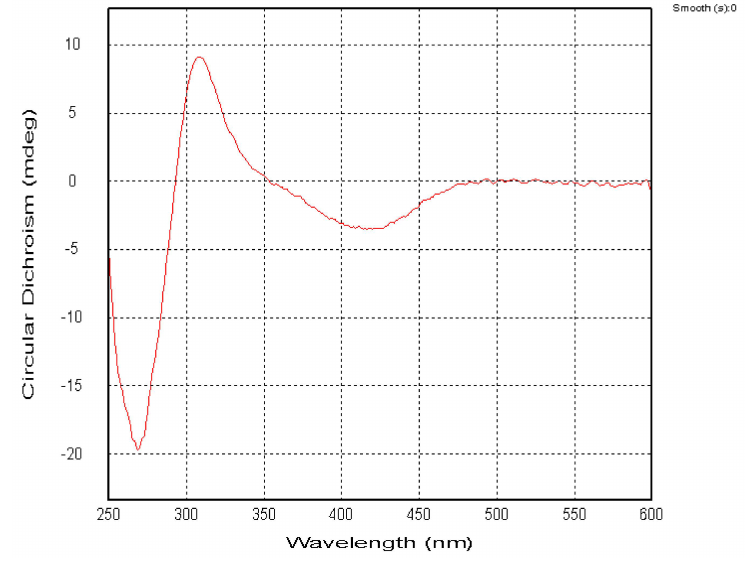
Figure 6. The circular dichroism (CD) spectrum of compound 7 in DMSO.